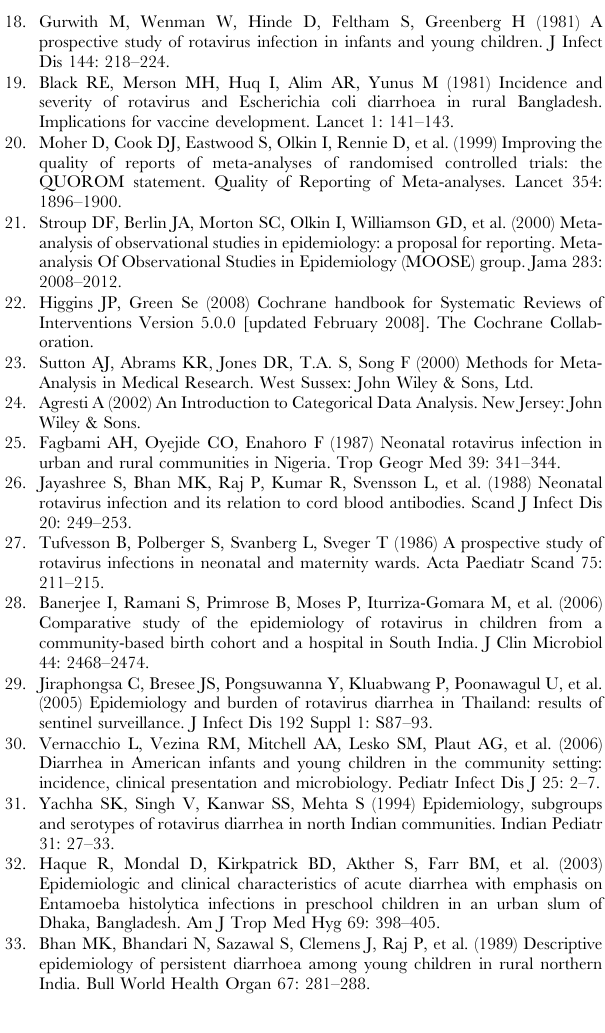
Figure S1 Incidence of symptomatic RV infections by